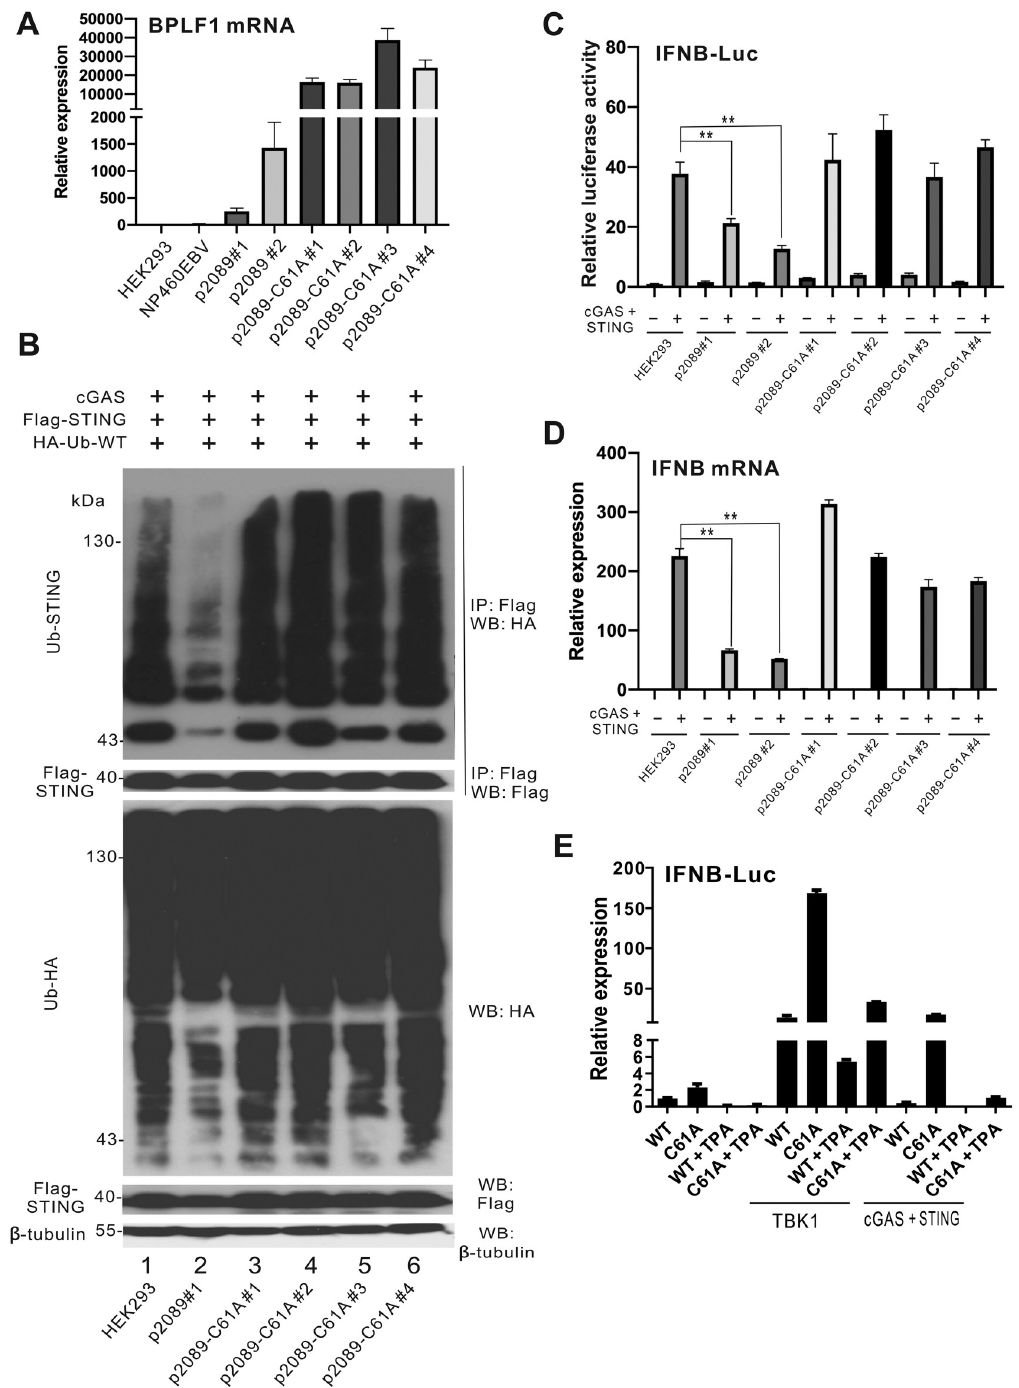
Fig 10. BPLF1 suppresses IFN- β production in EBV-infected cells. (A) BPLF1 mRNA expression in EBV + cells. HEK293, NP460EBV, HEK293p2089#1–2, HEK293p2089-C61A#1–4 cells were seeded into 6-well plates. The total cellular RNA was harvest 48 hours after transfection and the BPLF1 transcript expression levels were determined by RT-qPCR and the relative BPLF1 transcript expression levels were normalized to endogenous GAPDH transcript levels. (B) STING ubiquitination in cells carrying BPLF1-inactive EBV. HEK293, HEK293p2089 and HEK293p2089-C61A#1–4 cells were seeded into 60mm dishes. Cells were harvested 48 hours after transfection for co-immunoprecipitation. The Flag-tagged STING molecules were pulled down by the anti-Flag antibodies. The bound fraction of the immunoprecipitates (IP) and the total lysates (input) were analyzed by Western blotting (WB) with anti-HA, anti-Flag and anti- β -tubulin antibodies. (C) IFNB-Luc activation in cells